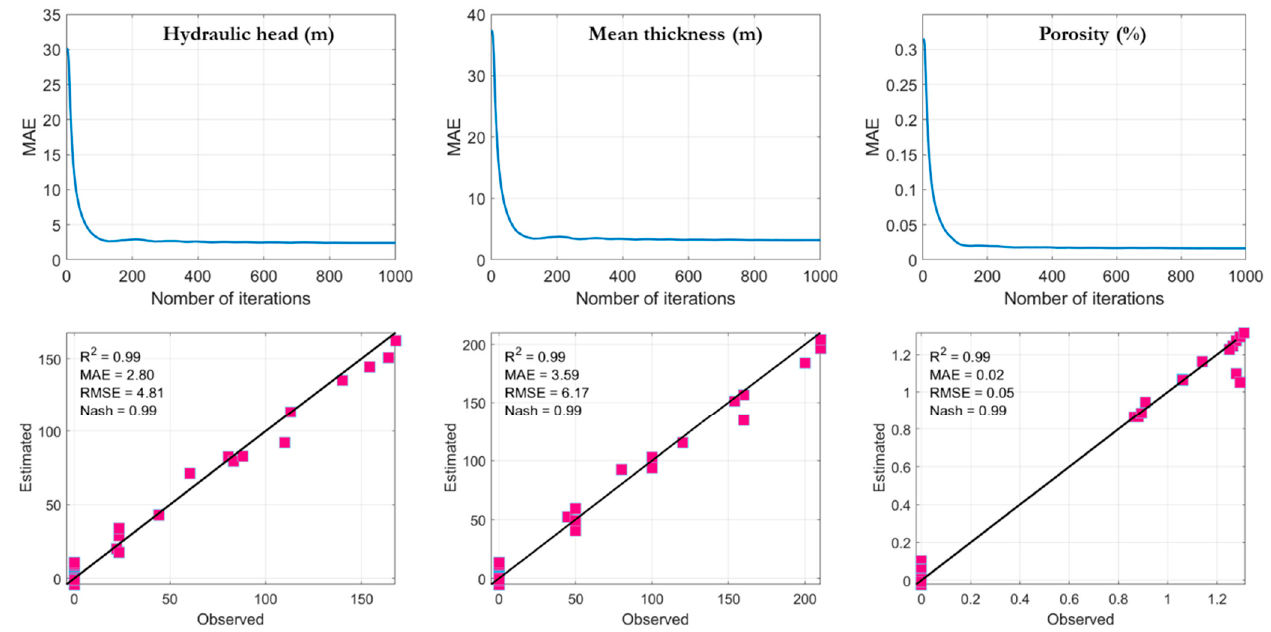
Figure 11. MAE vs. the number of iterations and observed vs. estimated values of the hydraulic head, the mean thickness, and the porosity based on the chosen optimal range.